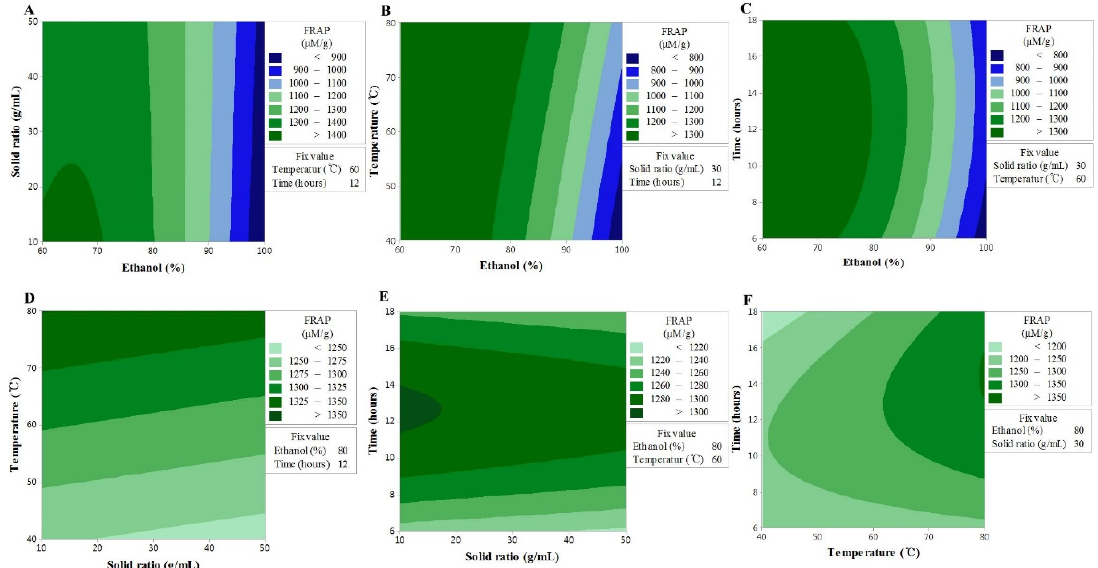
Figure 3. Contour plots showing the effect of ethanol concentration, solvent ratios, temperature, and time on ferric reducing antioxidant power. ( A ) solid ratios (g/mL) vs. ethanol concentration (%); ( B ) temperature (°C) vs. ethanol concentration (%); ( C ) time (h) vs. US ethanol concentration (%); ( D ) temperature (°C) vs. solid ratios (g/mL); ( E ) time (h) vs. solid ratios (g/mL); ( F ) time (h) vs. temperature (°C).